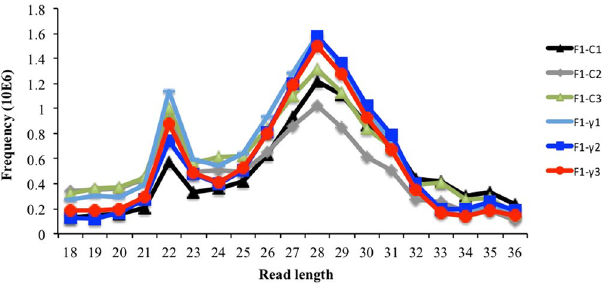
Figure 1. Reads length distribution of raw sequence reads after filtering by read length. Three biological replicate libraries per group of F 1 generation (5.5 hpf embryos) from parents exposed to 8.7 mGy/h of γ-radiation (F 1 -γ) and control parents (F 1